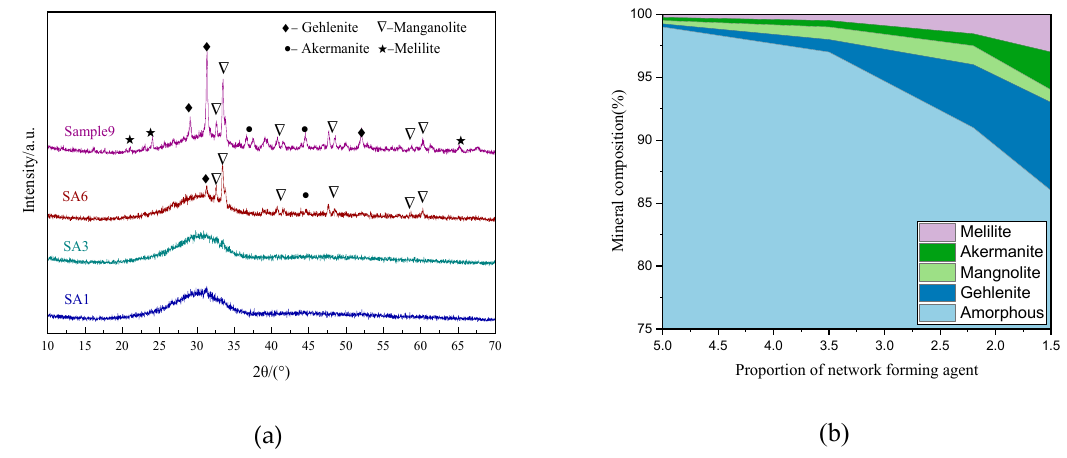
Figure 2. Mineral composition of blast furnace slag with different S/A: ( a ) XRD patterns; ( b ) quantitative analysis. 206